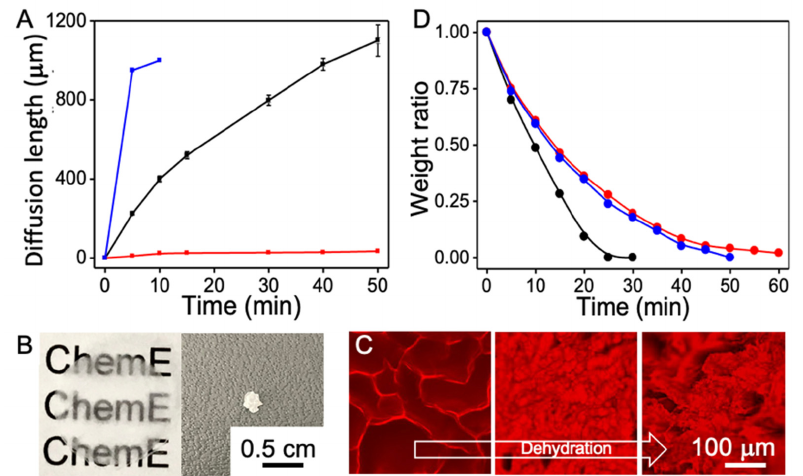
Figure 3. Molecular diffusion in hydrogels: ( A ) BSA in hydrogels with aligned channels (blue), rhodamine 6G in hydrogels with random pores (black), and BSA in hydrogels with random pores (red). Digital images ( B ) of hydrogels before (left) and after (right) dehydration. Fluorescent images ( C ) of hydrogels at transverse direction during dehydration. Weight ratio of water in the hydrogel during dehydration ( D ).